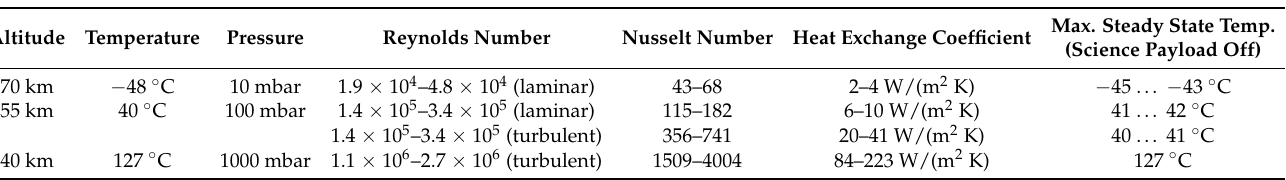
Table 9. Estimated ambient conditions and calculated convective heat transfer properties for a 300 mm long plate. The value range corresponds to wind speeds between 40 m/s and 100 m/s.